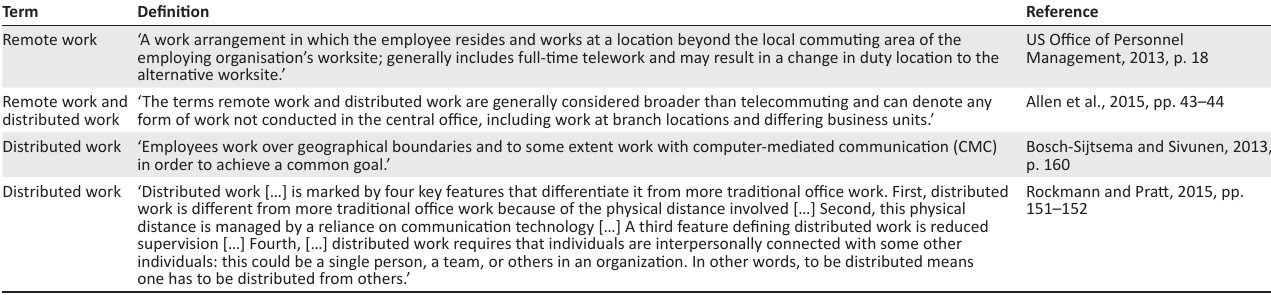
TABLE 2: A selection of remote and distributed work